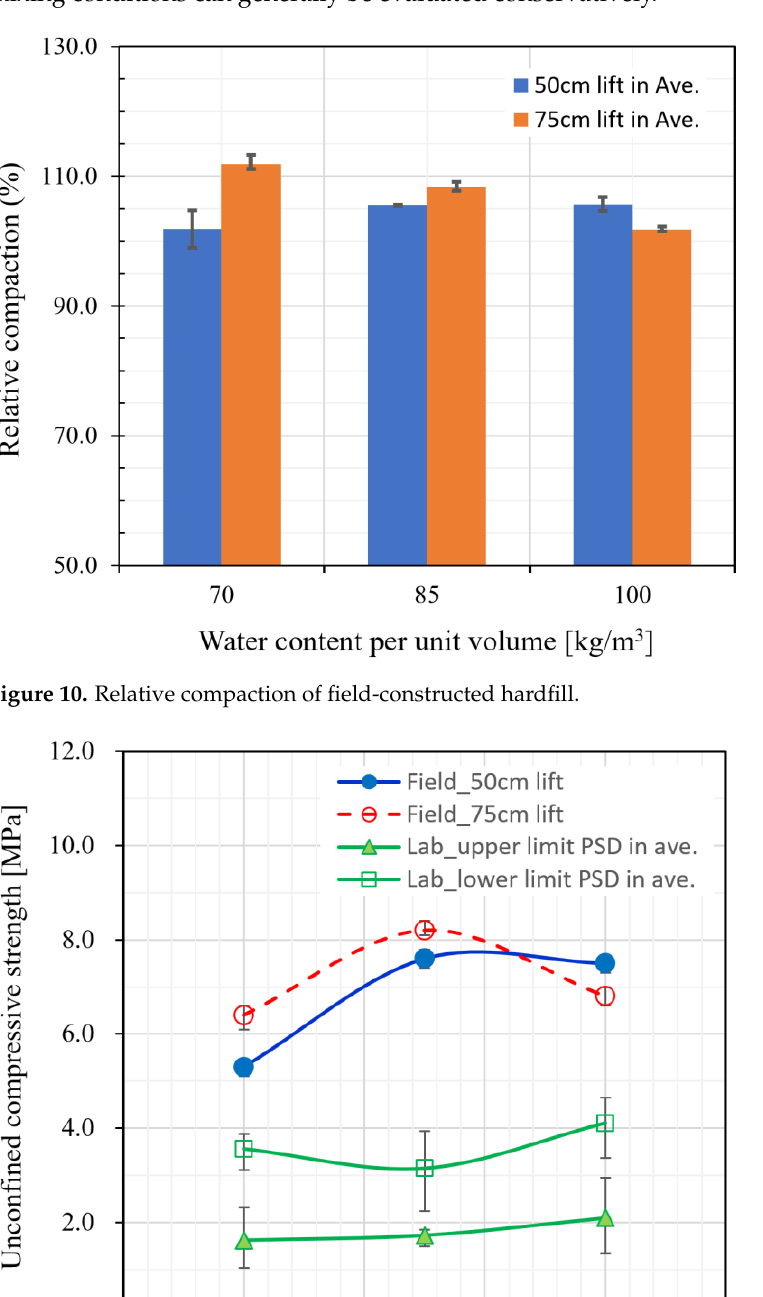
Figure 9. Compaction results for field-constructed hardfill (dry unit weight).